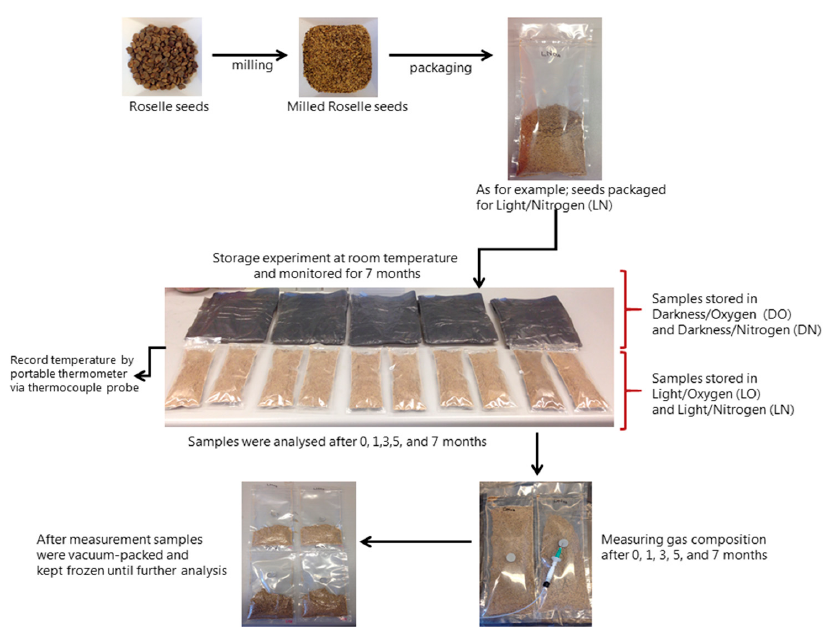
Figure 8. Diagram of packaging and storage conditions.